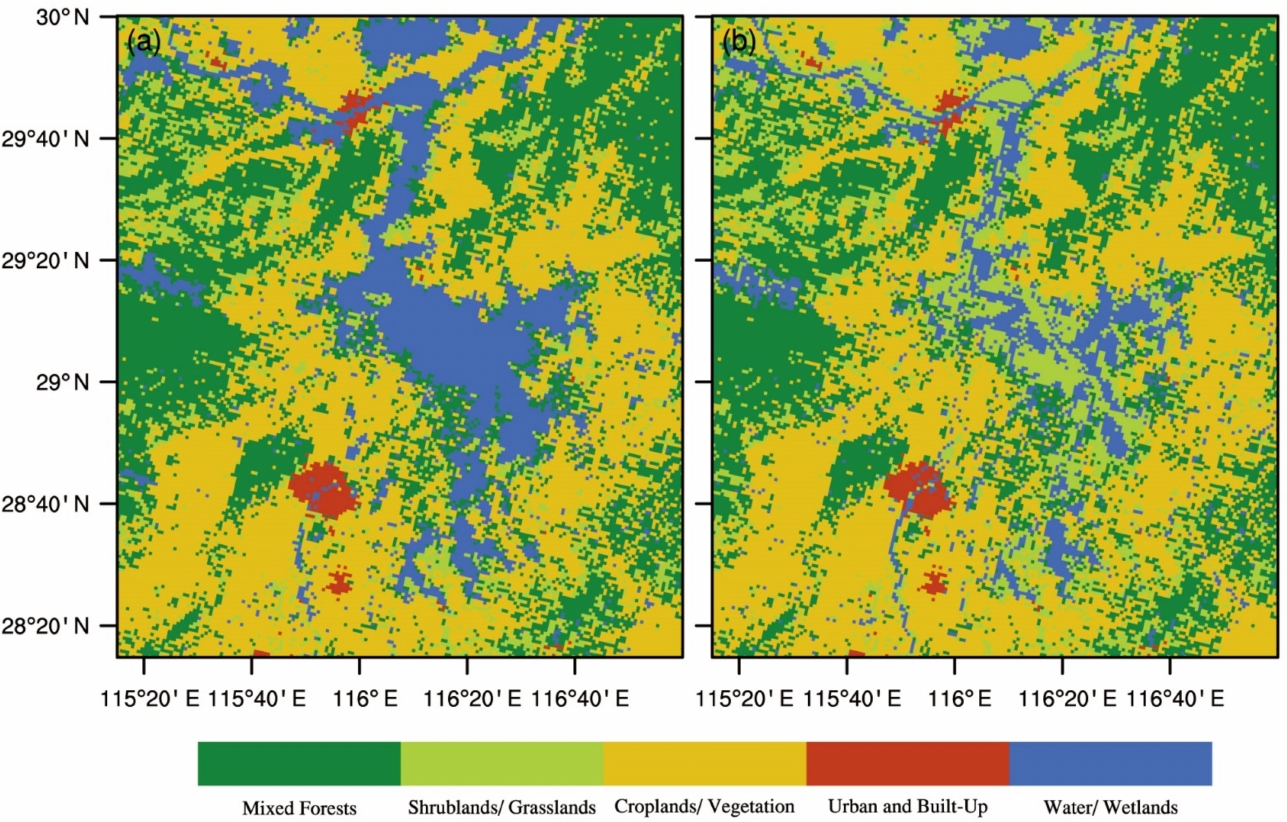
Figure 1. Land-use maps in wet ( a ) and dry ( b )